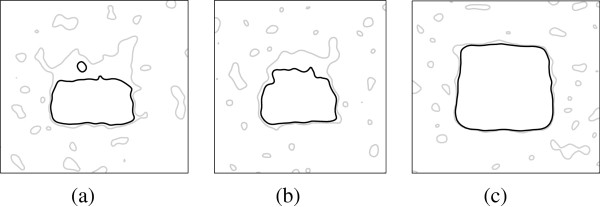
The identified region with p < 0.05, through a voxel-by-voxel based t-test (gray contour) and the permutation test (black contour), given the average dose difference of (a) 0.5 Gy, (b) 2 Gy and (c) 10 Gy.